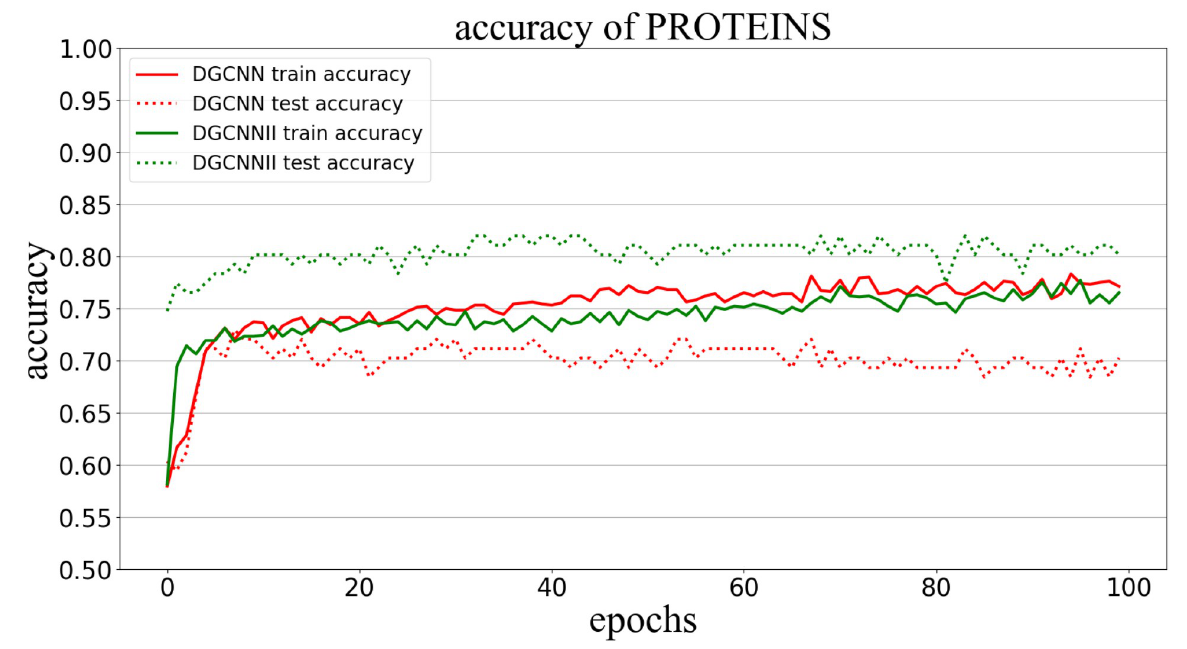
Fig 8. Comparison of graph classification accuracy between DGCNNII and DGCNN on PROTEINS dataset.